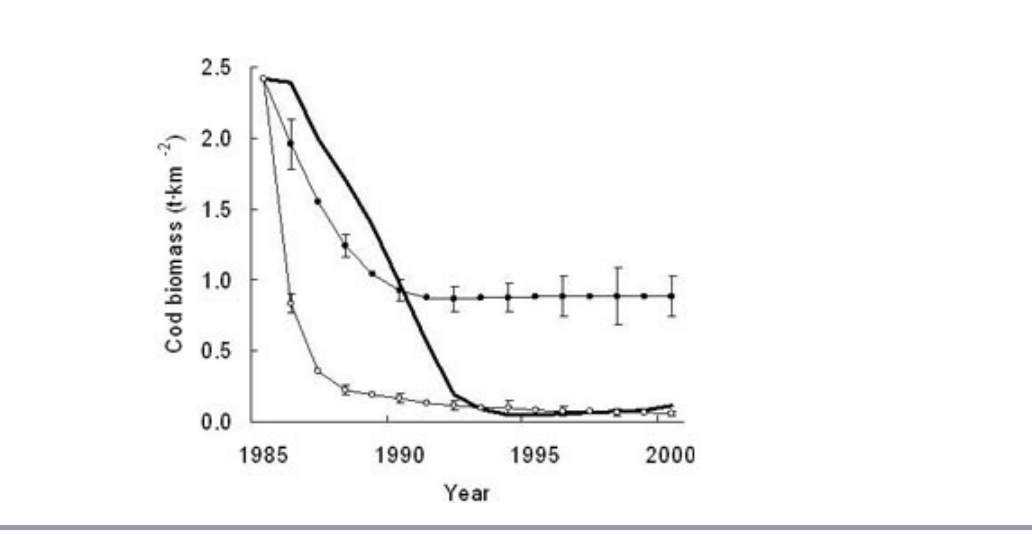
Fig. 2 . Atlantic cod biomass profile calculated from a virtual population analysis (solid line) and optimal biomass profiles calculated by maximizing net present values at discount rates of 0% (solid circles) and 20% (open circles). Modeling was performed using the Ecopath software suite (www.ecopath.org). A Monte Carlo procedure was used to vary basic Ecopath parameters (biomass, production and consumption) for all species groups ( n = 20, CV = 0.2). Error bars indicate ±1 standard deviation around the mean. This ecosystem model was adapted from Ainsworth and Sumaila